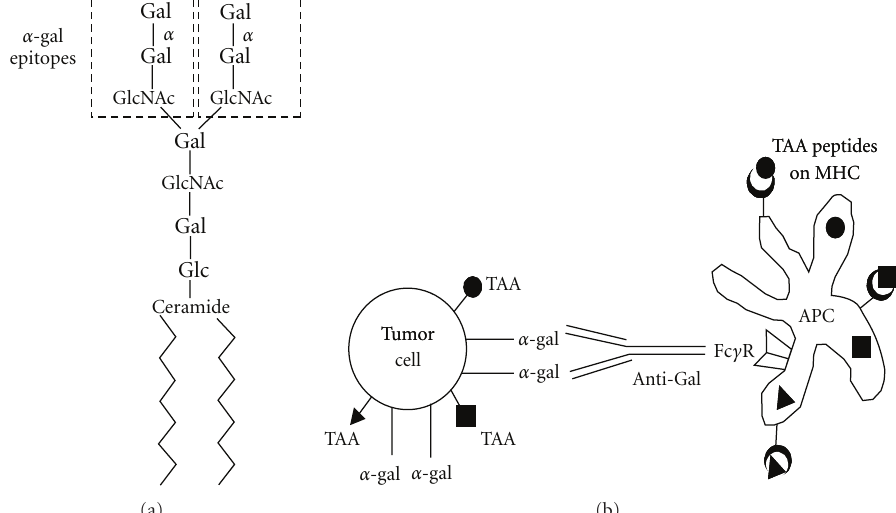
Figure 1: (a) Ceramide decahexoside as a representative α -gal glycolipid. This glycolipid has 10 carbohydrate branched chain. The α -gal epitope (Gal α 1-3Gal β 1-4GlcNAc-R) marked by the broken line rectangles caps both carbohydrate branches. The terminal α -galactosyl (Gal) unit is linked α 1,3 to the penultimate Gal of the carbohydrate chain by the glycosylation enzyme α 1,3galactosyltransferase ( α 1,3GT). The lipid portion of α -gal glycolipids (ceramide) anchors the carbohydrate portion in the cell membrane via the two fatty acid tails. (b) Anti- Gal-mediated targeting of tumor cells to APC in lesions injected with α -gal glycolipids. Intratumoral injection of α -gal glycolipids results in insertion of these glycolipids in tumor cell membranes. Anti-Gal IgG binds in situ to α -gal epitopes on the inserted glycolipids. Subsequent interaction between the Fc portion of the bound anti-Gal and Fc γ R on the APC (illustrated as a dendritic cell) induces uptake of intact or lysed tumor cells by APC, resulting in e ff ective internalization of the tumor-associated antigens (TAA). Internalized TAA are processed and various immunogenic TAA peptides ( (cid:2) , (cid:2) , (cid:3) ) are presented by the APC in association with class I and class II MHC molecules. These immunogenic peptides can activate tumor specific cytotoxic and helper T cells and elicit a protective antitumor immune